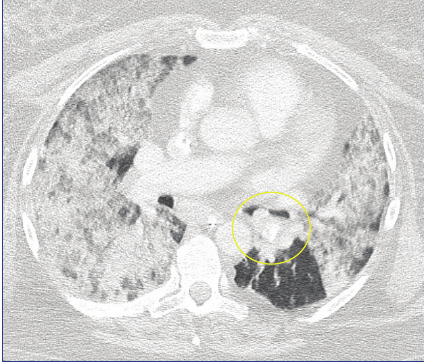
Figure 4: CTA chest showing bilateral ground glass opacities and highlighting the left endobronchial lesion (yellow circle).